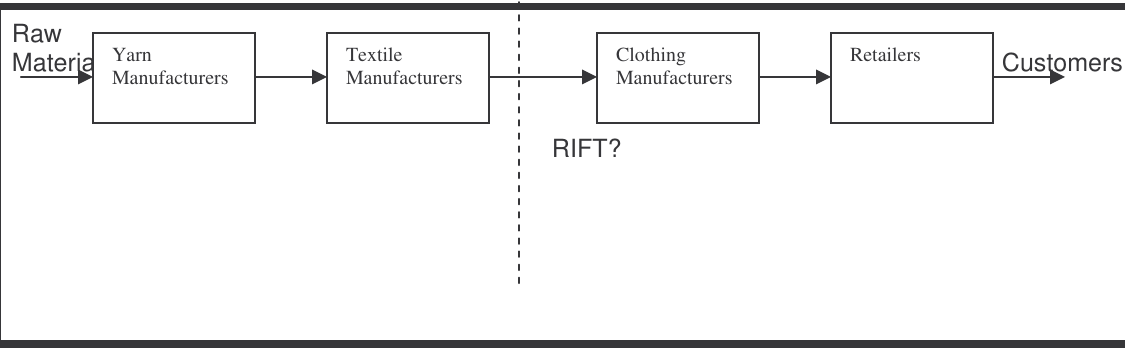
Figure 1: Textile-Clothing Pipeline